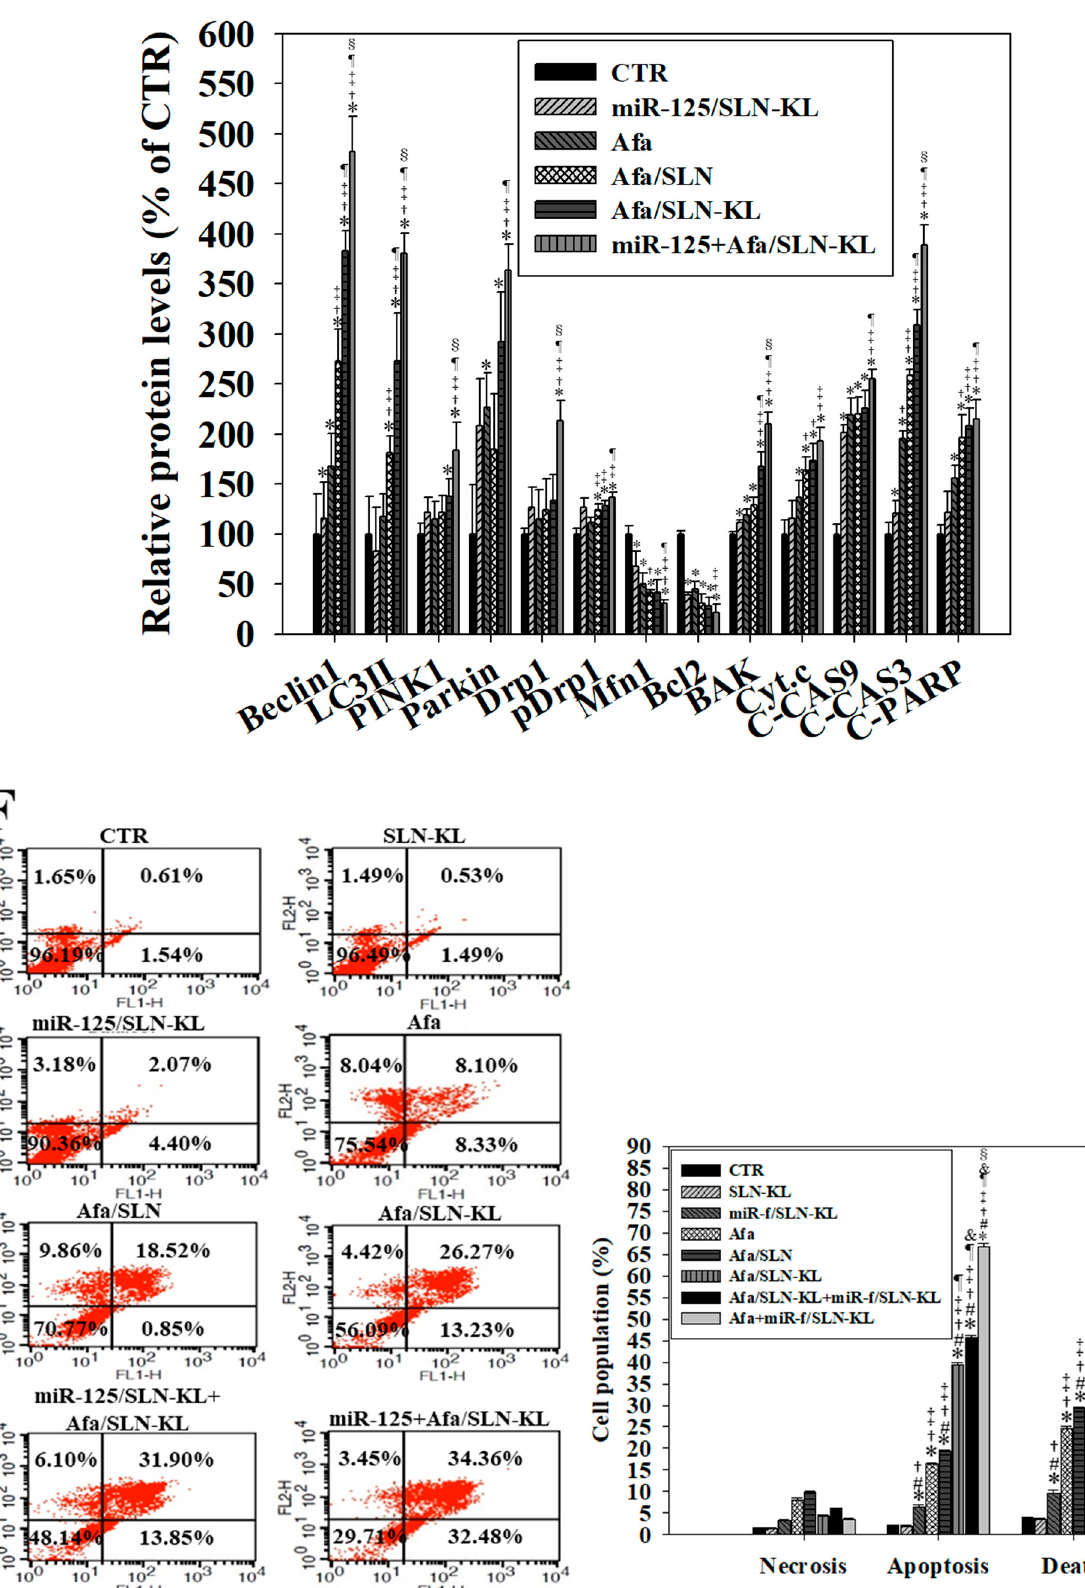
Figure 6. Effects of various miR ‐ 125 (100 nM) and/or Afa (300 nM) formulations on mitophagy and mitochondrion ‐ mediated apoptosis pathway after 24 h treatment in AGS cells. ( A ) Scheme of mitophagy and mitochondrion ‐ mediated apoptosis pathway ( ↑ : increase; ↓ : decrease). ( B ) Images of various formulations on mitophagy by using confocal laser scanning microscopy (CLSM). Blue: